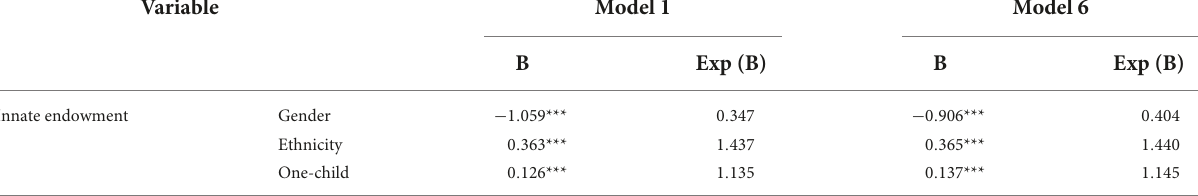
TABLE 3 Results of regression analysis of innate endowment factors on the dependent variable.